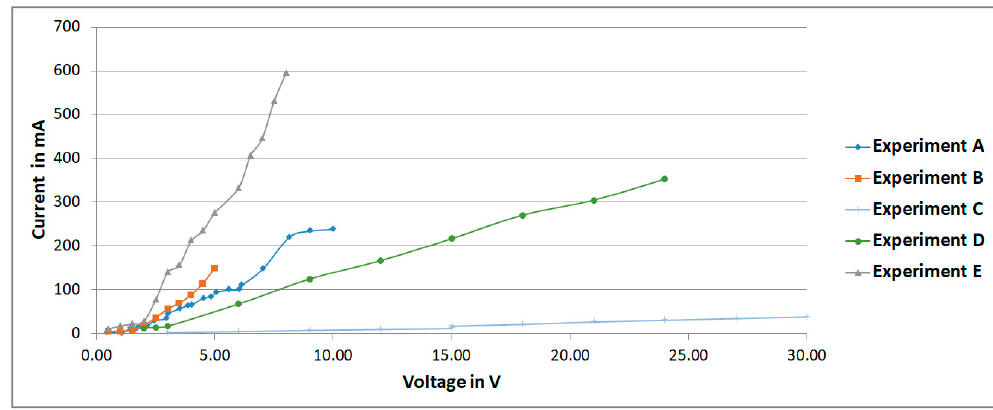
Figure 8. Electric parameters linear relationship for experiments of Table 1.